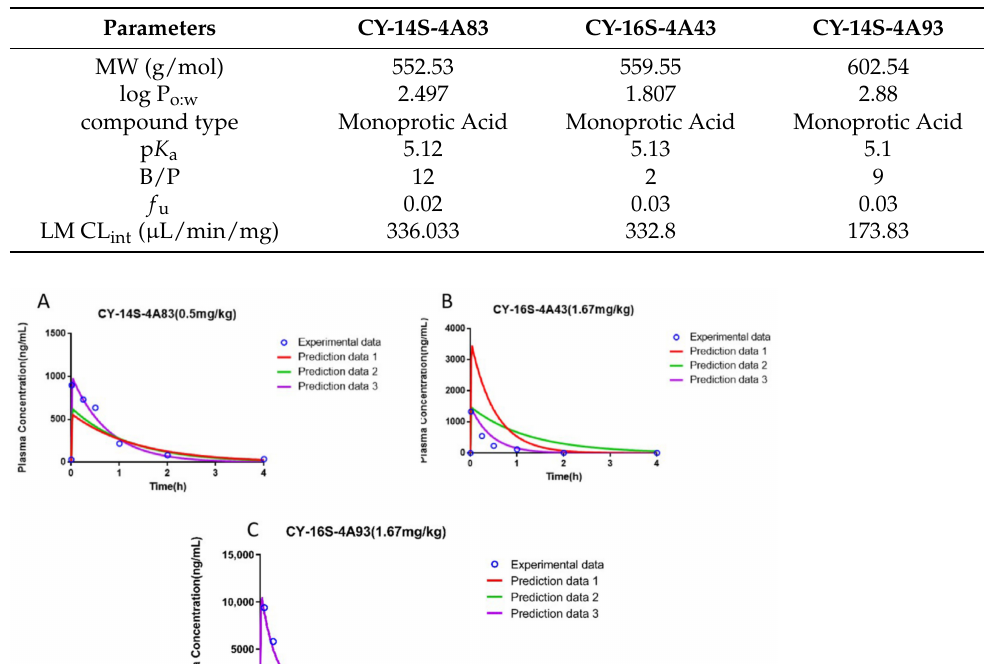
Table 5. Parameters of CY-14S-4A83, CY-16S-4A43, and CY-16S-4A93 used in the PBPK modeling.